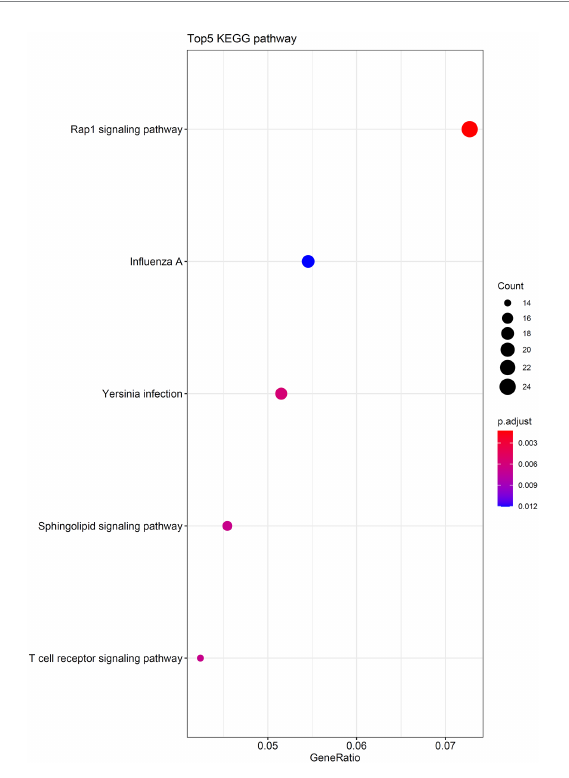
FIGURE 6 Top five GO terms enriched by the genes converted by the top 1,025 methylation features.